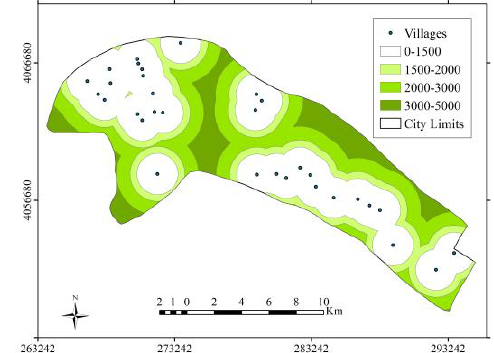
Figure 11. The map of existing villages in the study area and the distance map of villages (The unit of distance is